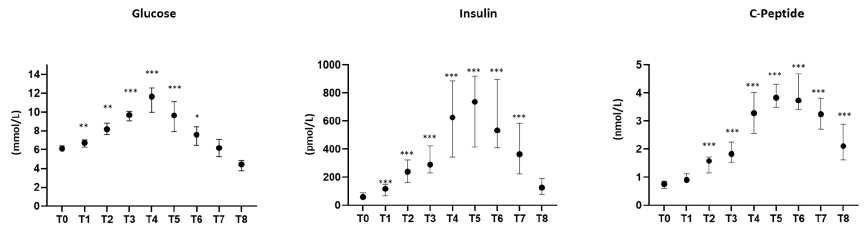
Figure 1. Levels of glucose, insulin, and C-peptide at baseline (T0) and for 180 min following an oral glucose load in prediabetic patients. Data are expressed as median and interquartile range. n = 18; * p < 0.05, ** p < 0.005, *** p < 0.0005 vs.